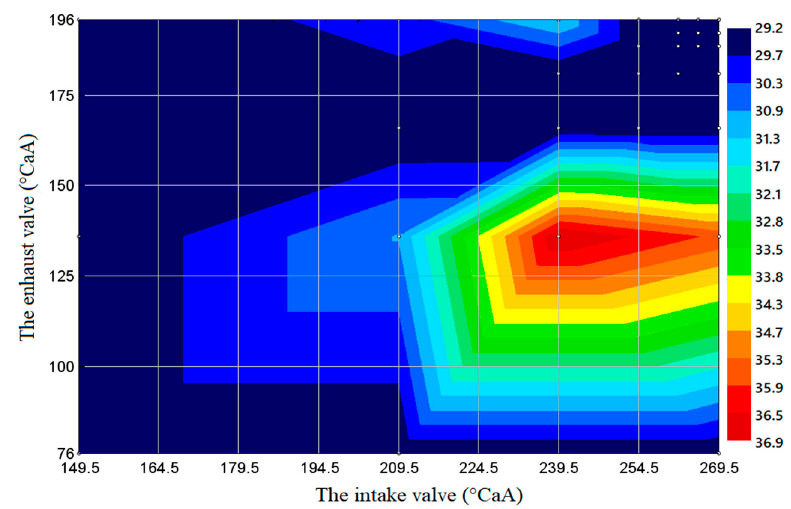
Figure 15. 100% load condition.